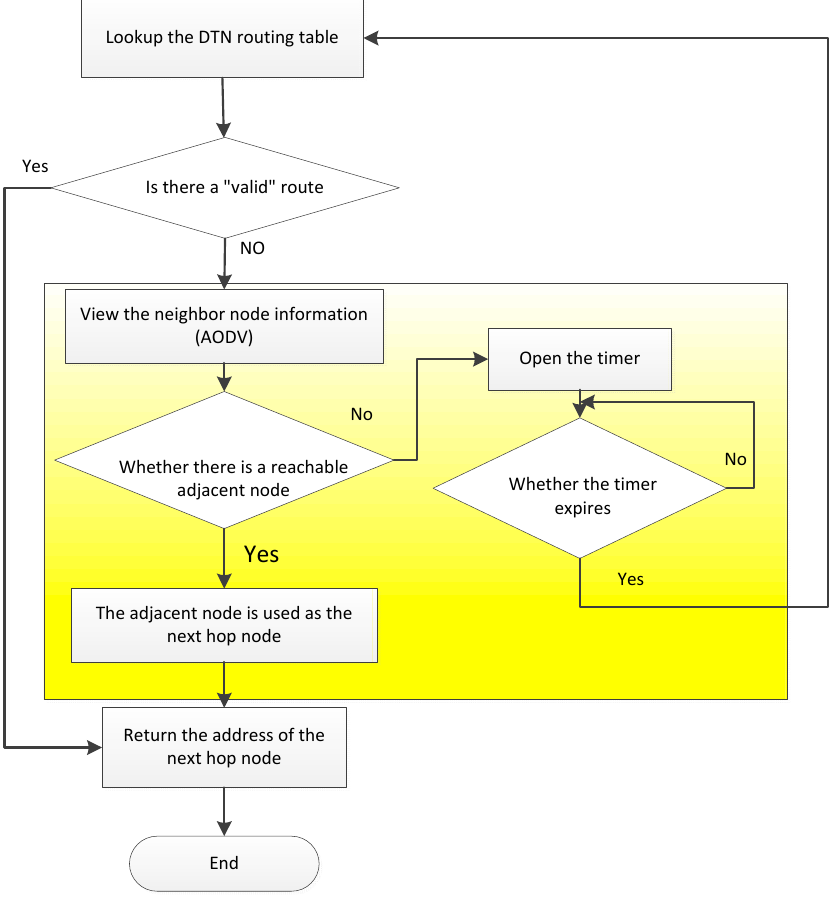
Figure 10. Routing discovery process.